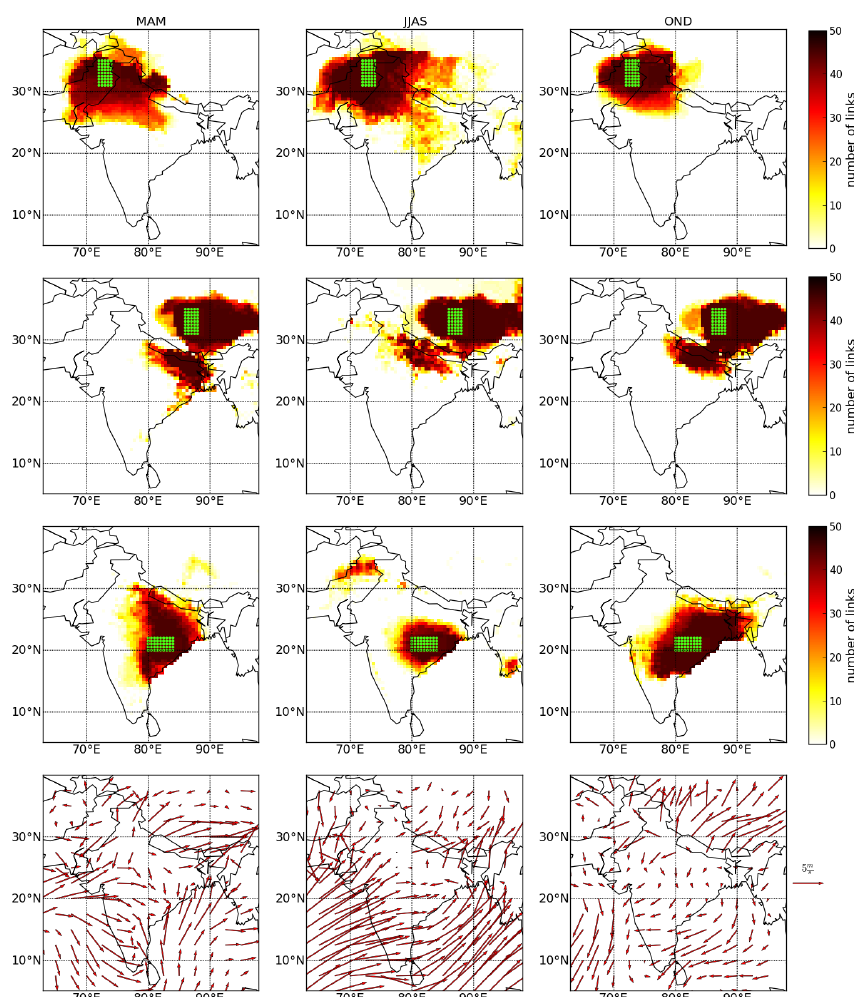
Figure 7. Links between a set of 45 reference grid points and other grid points and the surface wind vector mean between 1951 and 2007. From top to bottom: North Pakistan (NP), Tibetan Plateau (TP), Eastern Ghats (EG) and the surface wind vector mean (NCEP/NCAR